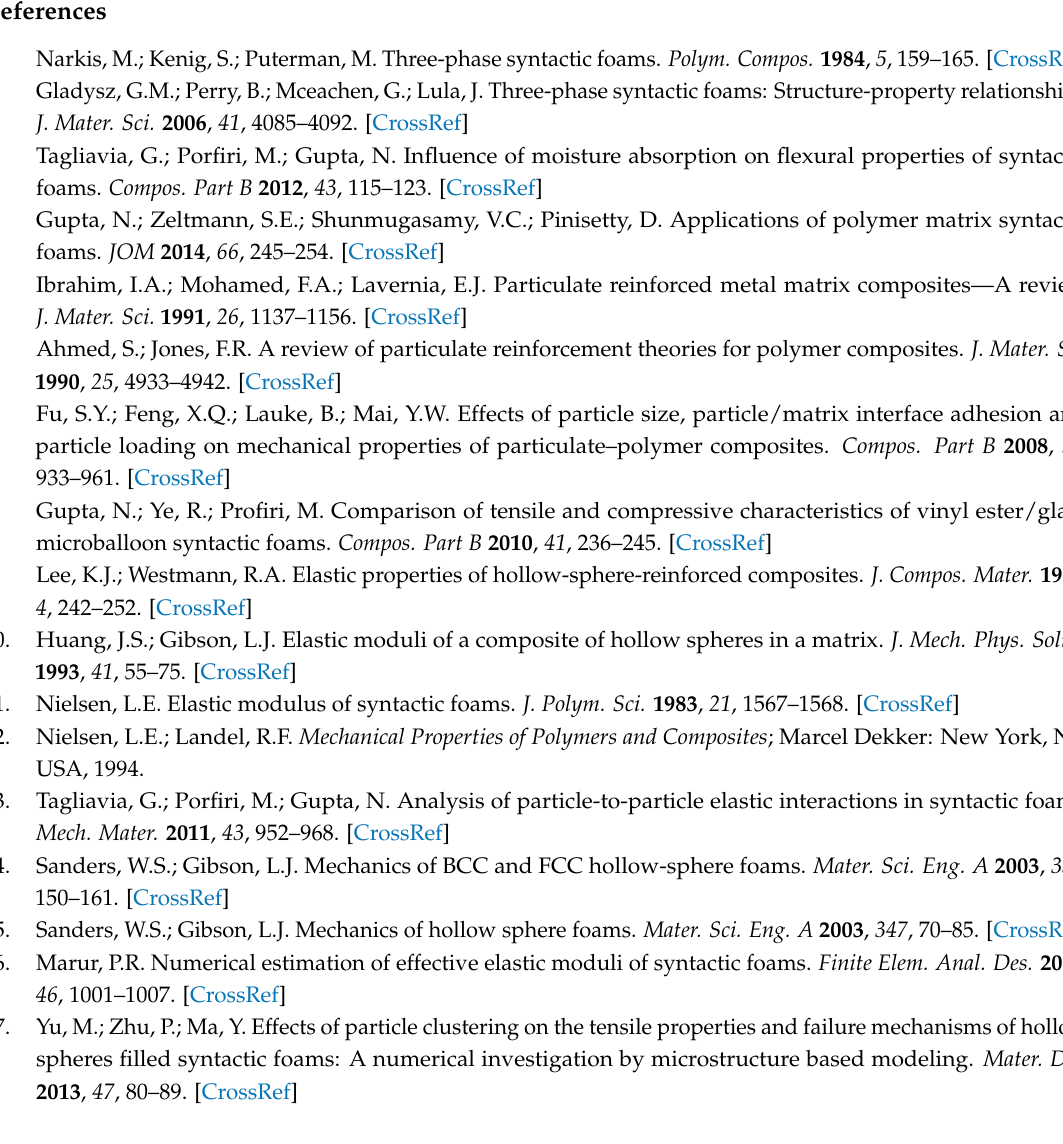
Figure S1: Models with different finite element meshes on microspheres, Figure S2: Comparison of tensile moduli obtained by mixed model for ζ = 0% (fully bonded) with analytical models with 30% microspheres without void, Figure S3: Comparison of tensile moduli obtained by mixed model for ζ = 33.3%. The mixed model had microsphere volume fraction of 30% in total (bonded microspheres by 20% and debonded microspheres by 10% in volume fraction), Figure S4: Comparison of tensile moduli obtained by mixed model for ζ = 66.6%, Table S1: Tensile elastic moduli obtained by mixed models with different finite element meshes in